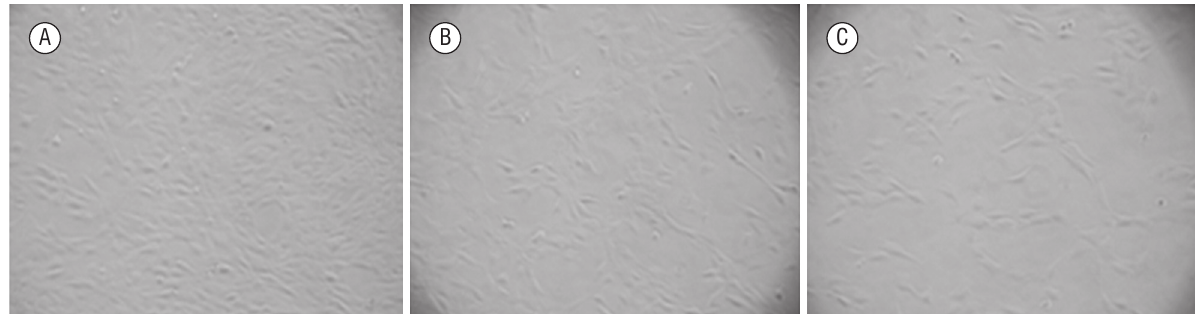
Figura 1 - Avaliação da morfologia das células musculares: (A) controle; (B) tratadas com o US; (C) tratadas com o